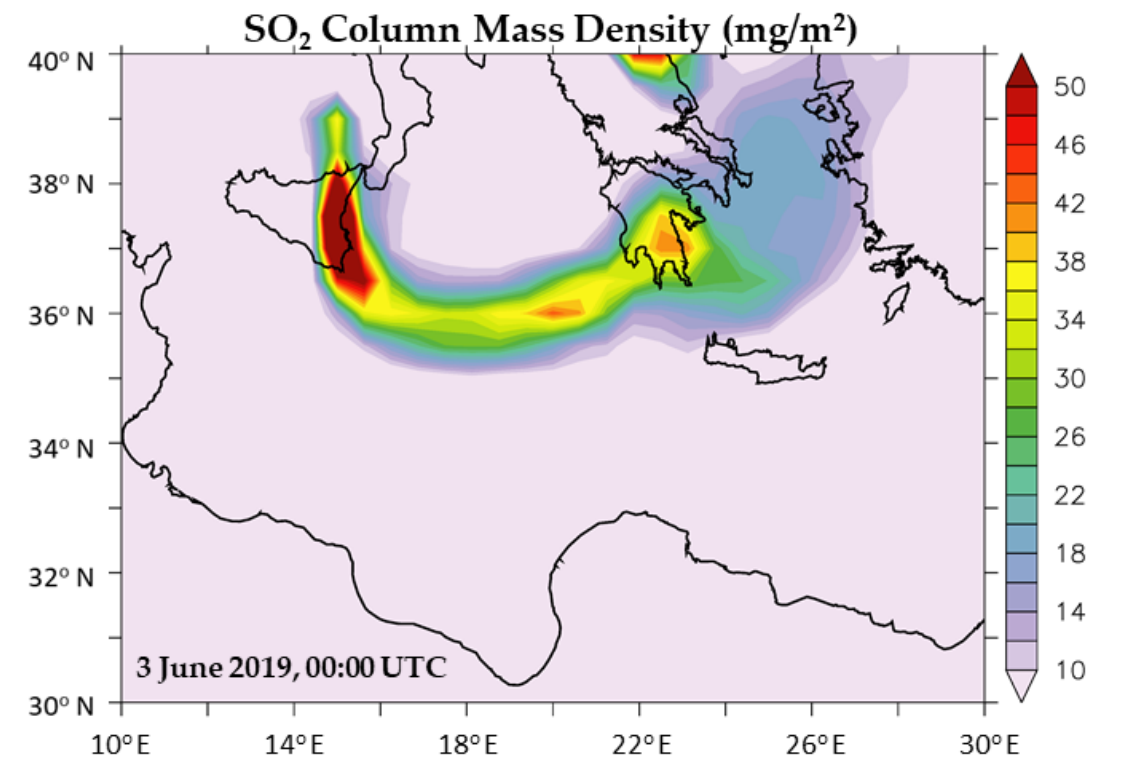
Figure 6. Simulated sulfates mass density (mg/m 2 ) originating from Etna, by MERRA-2 reanalysis on 3 June 2019, 00:00 UTC.